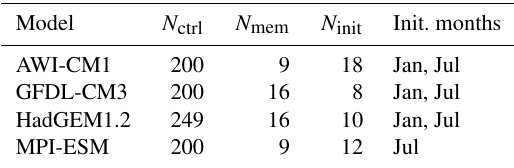
Table 1. Brief summary of the APPOSITE simulations used in this study. The columns are, from left to right, model name, number of control simulation years ( N ctrl ), number of ensemble members ( N mem ), number of initialized predictions ( N init ), and the initializa- tion